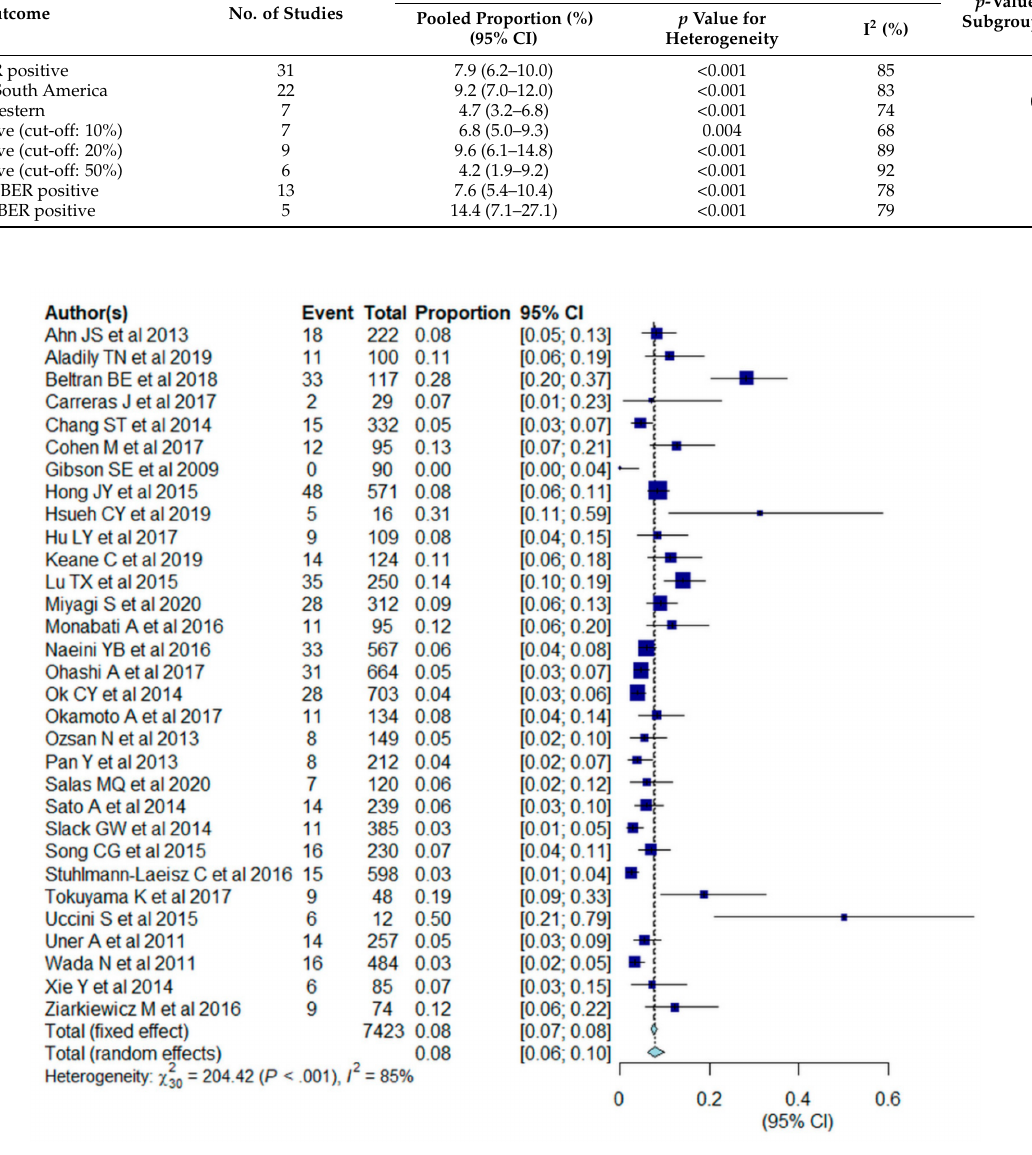
Figure 2. Forest plots of the pooled proportion of Epstein-Barr virus-positive (EBV+) diffuse large B cell lymphoma (DLBCL) in the included studies ( n =